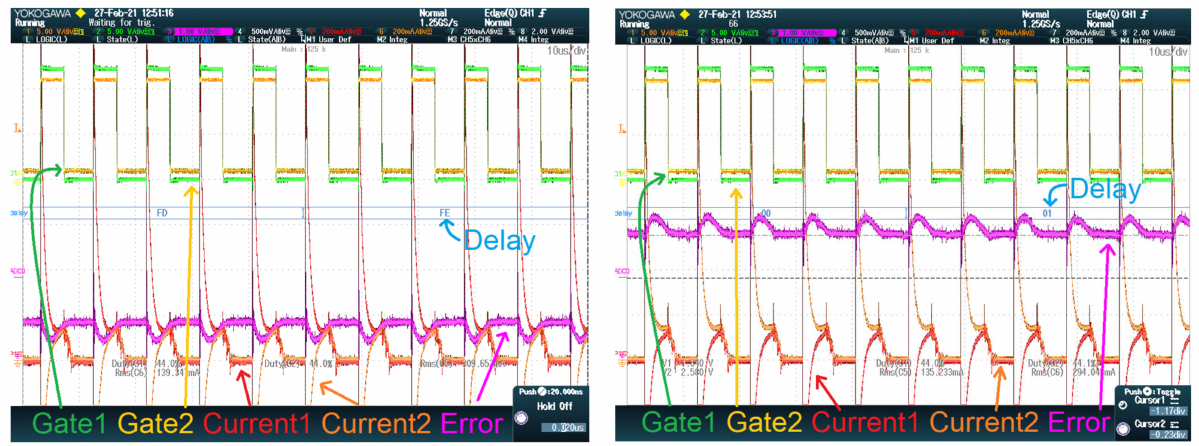
Figure 12. Fixed 62 ns timing error between the two sub-forwards: negative error ( left ) and positive error ( right